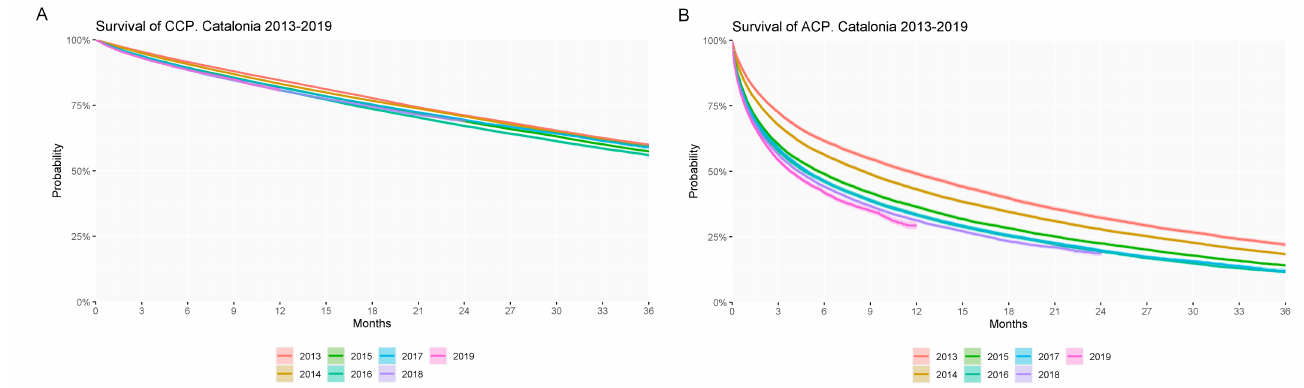
Figure 5. Probability of survival up to 3 years of ( A ) chronic complex patients (CCPs) and ( B ) advanced chronic patients (ACPs) according to year of identification.